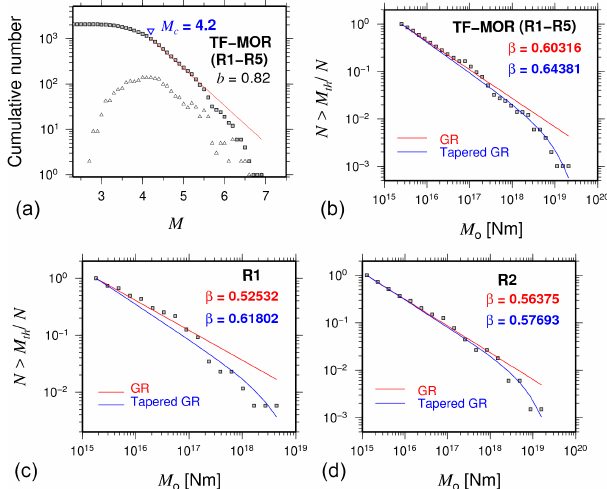
Figure 5. (a, b) The cumulative annual seismic moment frequency distribution for the transform fault zone and mid-ocean ridge (TF- MOR) events (regions R1 to R5). The blue lines are the moment, tapered Gutenberg–Richter distributions. The red lines represent the ordinary moment Gutenberg–Richter distributions. (c, d) The sub- regions that do not follow an ordinary moment Gutenberg–Richter distribution are subregions R1 and R2.